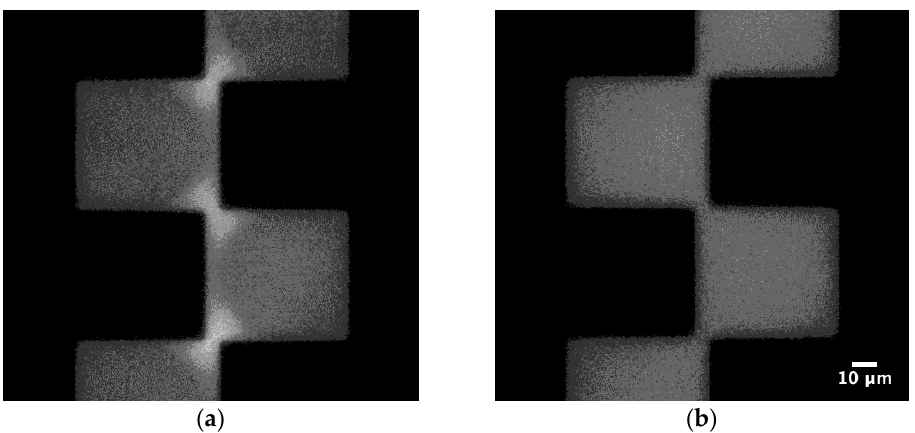
Figure 2. Typical images of exosome DEP. The fluorescent-labeled bovine milk exosomes were suspended in NaCl solution (20 µS/cm). ( a ) p-DEP at 1 MHz and ( b ) n-DEP at 100 kHz.